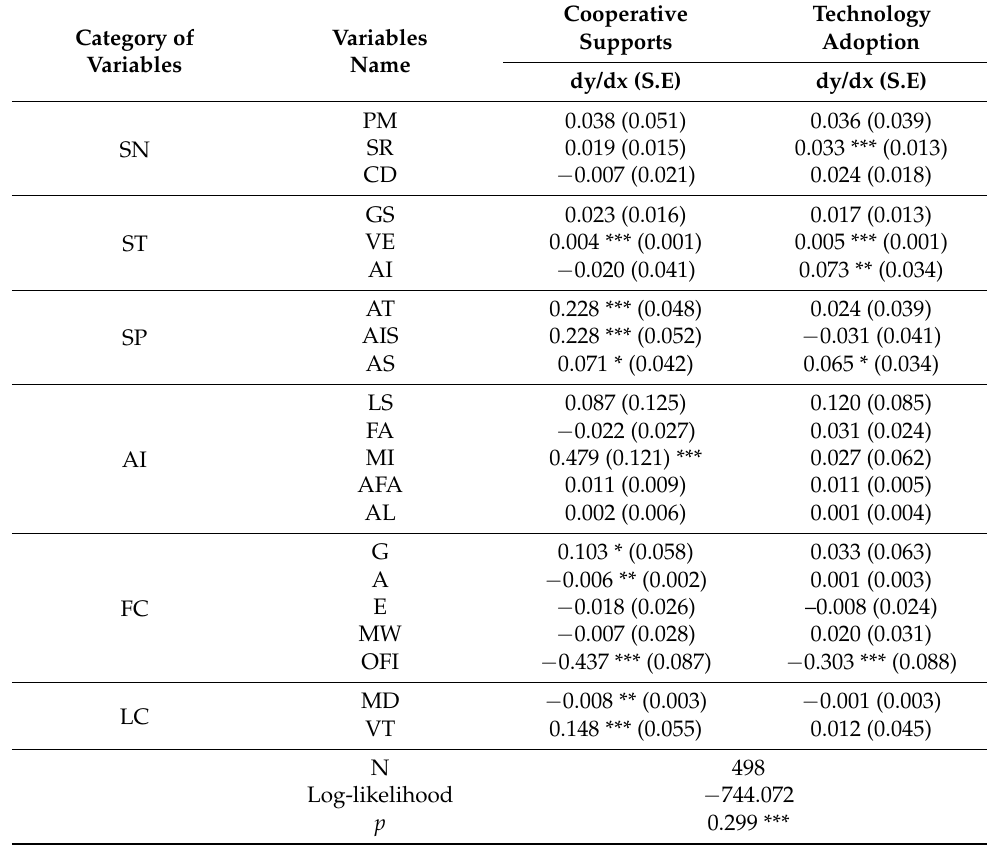
Cooperative Supports